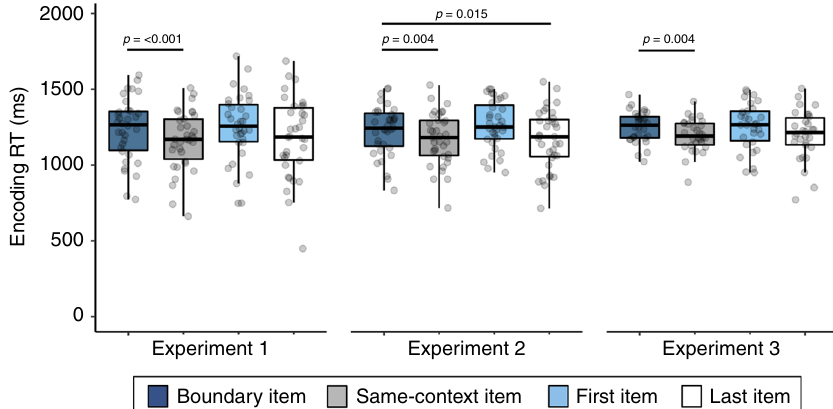
Fig. 2 Individuals are slower to respond to items appearing just after a tone switch, or event boundary, compared to other items in an event sequence. Values represent average response times (RTs) for the indoor/outdoor item judgments during sequence encoding. Colored boxplots represent 25th – 75th percentiles of the data, the center line the median, and the error bars the s.e.m. Overlaid dots represent individual participants (Experiment 1: n = 34; Experiment 2: n = 35; Experiment 3: n = 30). Two-tailed paired pairwise t -tests were performed to test for signi fi cant differences between judgment response times for boundary items, fi rst items, last items, and same-context items. These t -tests were planned, so no adjustments were made for multiple comparisons. The results for the boundary compared to same-context trial comparisons from the fi rst experiment directly replicated two follow-up experiments. Source data are provided as a Source Data fi le.